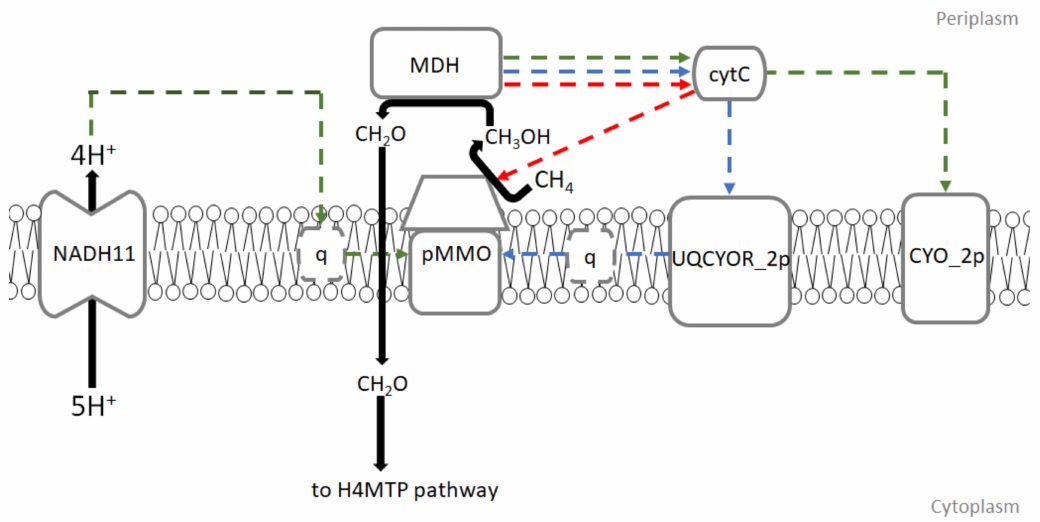
Figure 1. Modes of electron transfer to pMMO in iMsOB3b model developed in this study. The dotted lines represent possible electron flow in 3 di ff erent modes of electron transfer. The green dotted lines refer to electron flow in redox-arm mode. The blue dotted lines refer to electron flow in uphill electron transfer mode. The red dotted lines represent electron flow during direct coupling mode. pMMO refers to particulate methane monooxygenase, q refers to ubiquinone, cytC refers to cytochrome C, NADH11 refers to ubiquinone oxidoreductase, UQCYOR_2p refers to ubiquinol-cytochrome-c reductase, CYO_2p refers to cytochrome C oxidase, H4MTP refers to tetrahydromethanopterin